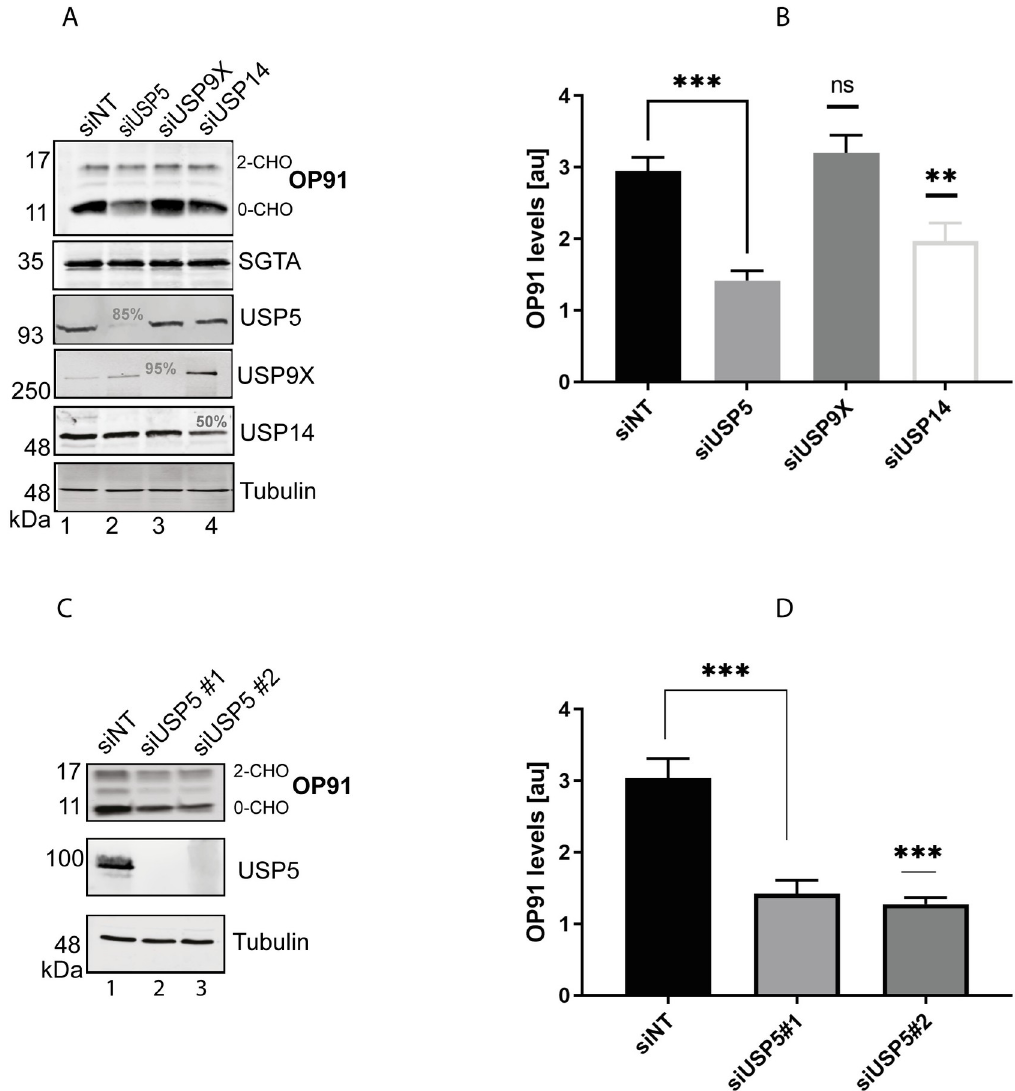
Fig 2. Knocking down USP5 reduces the steady state of a model MLP. A) HeLa TRex Flp-In cells stably expressing OP91 after induction, were seeded at 50% confluence and transfected with 1 nM of siRNAi targeting the indicated DUBs. OP91 expression was induced 48 h later and cells grown for 20 hrs post induction. Total cell lysates were prepared, and products analysed by Western blotting with antibodies against OP91, SGTA, USP5, USP9X, USP14 and tubulin (loading control) using fluorescence- based detection (LICOR). The % knockdown efficiency is indicated for each DUB in lane 2, 3 and 4. B) OP91 signals were quantified using Odyssey 2.1 software and normalised to the tubulin loading control, values show standard errors for n = 3. Pairwise comparisons relative to the NT control, were performed using GraphPad Prism. Student t-test: P > 0.05 = ns, P � 0.05 = � , P � 0.01 = �� , P � 0.001 = ��� C) HeLa TRex Flp-In cells stably expressing OP91 were transfected with non-targeting siRNAi or two independent siRNAi duplexes targeting USP5. Cells were treated as described in A, followed by blotting for OP91, USP5 and tubulin. D) OP91 signals were quantified using Odyssey 1 Fc Imaging system and normalised to the tubulin loading control, values show standard errors for n = 3. Pairwise comparisons relative to the NT control, were performed using GraphPad Prism. Student t-test: P > 0.05 = ns, P � 0.05 = � , P � 0.01 = �� , P � 0.001 = ��� and P � 0.0001 = ����